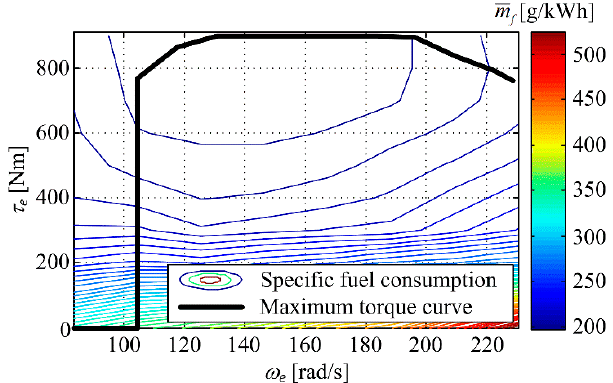
Figure 3. Specific consumption map and maximum torque curve of ICE.